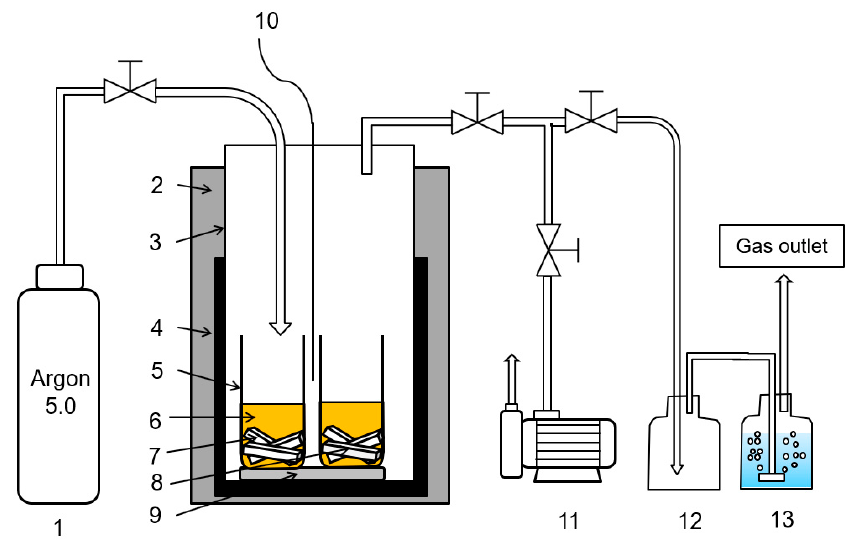
Figure 2. Schematic diagram of the experimental set-up for high-temperature static exposure tests. 1: Gas bottle for argon 5.0 gas, 2: glass wool heat isolator, 3: steel tubing of Incoloy 800 H, 4: furnace, 5: glassy carbon crucible, 6: molten chloride salt (Test 1) or Ar gas (Test 2), 7: coupons of 3D-printed ZrO 2 ceramics, 8: coupons of 3D-printed Al 2 O 3 ceramics, 9: Al 2 O 3 plate, 10: thermocouple close to the molten salt, 11: vacuum pump, 12: security bottle (empty) to prevent reflux from the gas washing bottle, 13: bottle with NaOH solution for gas washing (removal of HCl and Cl 2